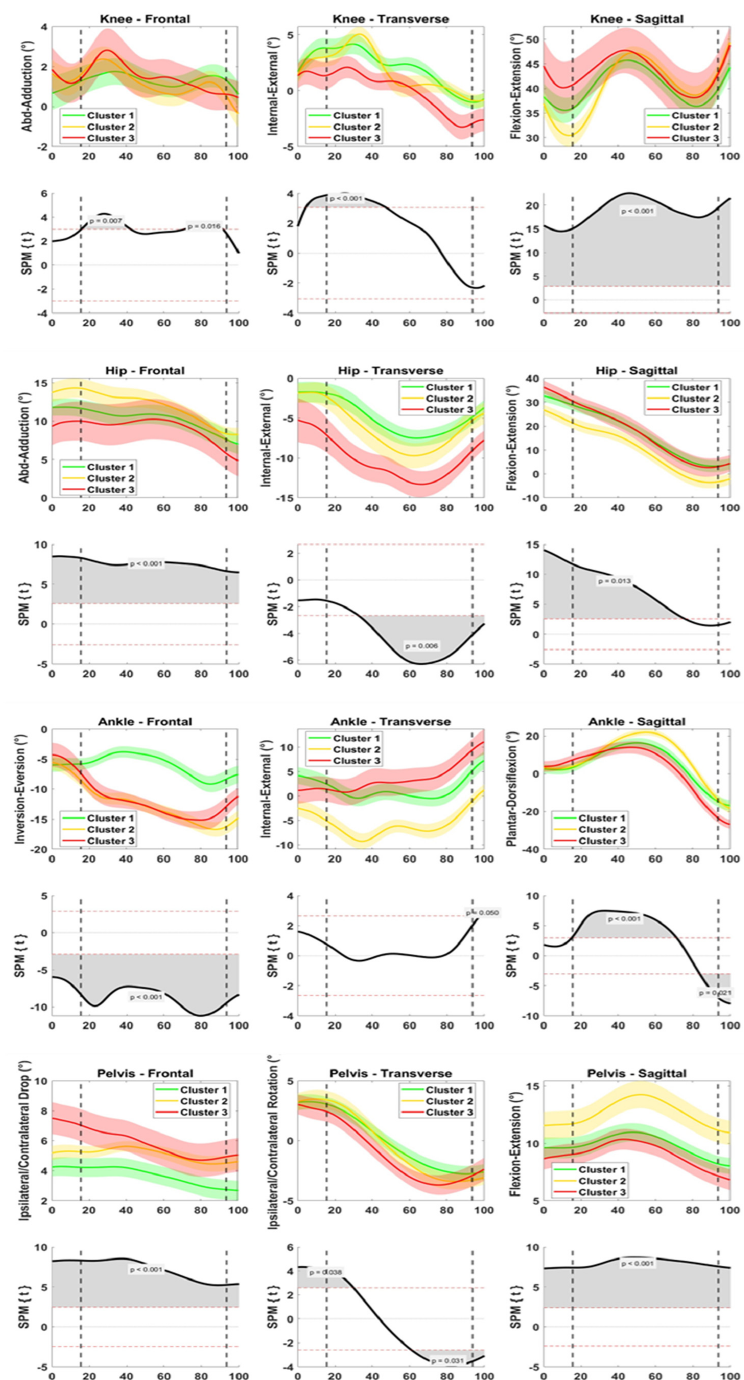
Figure 2. Joint kinematics of knee (1st row), hip (3rd row), ankle (5th row), and pelvis (7th row) collected on the field during change of direction exercises. Data are clustered according to the knee moments emerged in the lab (Cluster 1, green, “low-risk”; Cluster 2, yellow, “mid-risk”; Cluster 3, red, “high-risk”). Data are presented as mean and standard deviation on frontal (1st column), transverse (2nd column), and sagittal (3rd column) plane. One-way ANOVA through Statistical Parametric Mapping (SPM) was used to compare the groups (rows 2, 4, 6, 8 for knee, hip, ankle, and pelvis, respectively). Data are normalized from 50 ms prior to foot initial contact to 25 ms after toe-off. Dotted lines represent initial contact and toe-off. Positive rotations: flexion (dorsiflexion, anteversion) on sagittal plane, abduction (abduction, inversion, ipsilateral tilt) on frontal plane, and internal rotation (ipsilateral rotation) on transverse